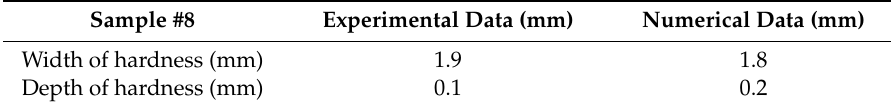
Table 5. Comparison of experimental and numerical dimensions (mm) of hardened zone.